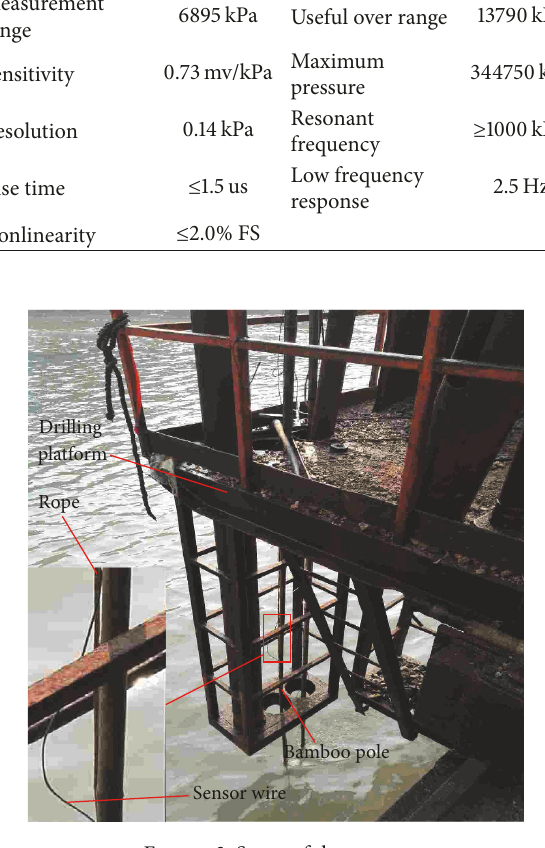
Figure 2: Setup of the sensor.